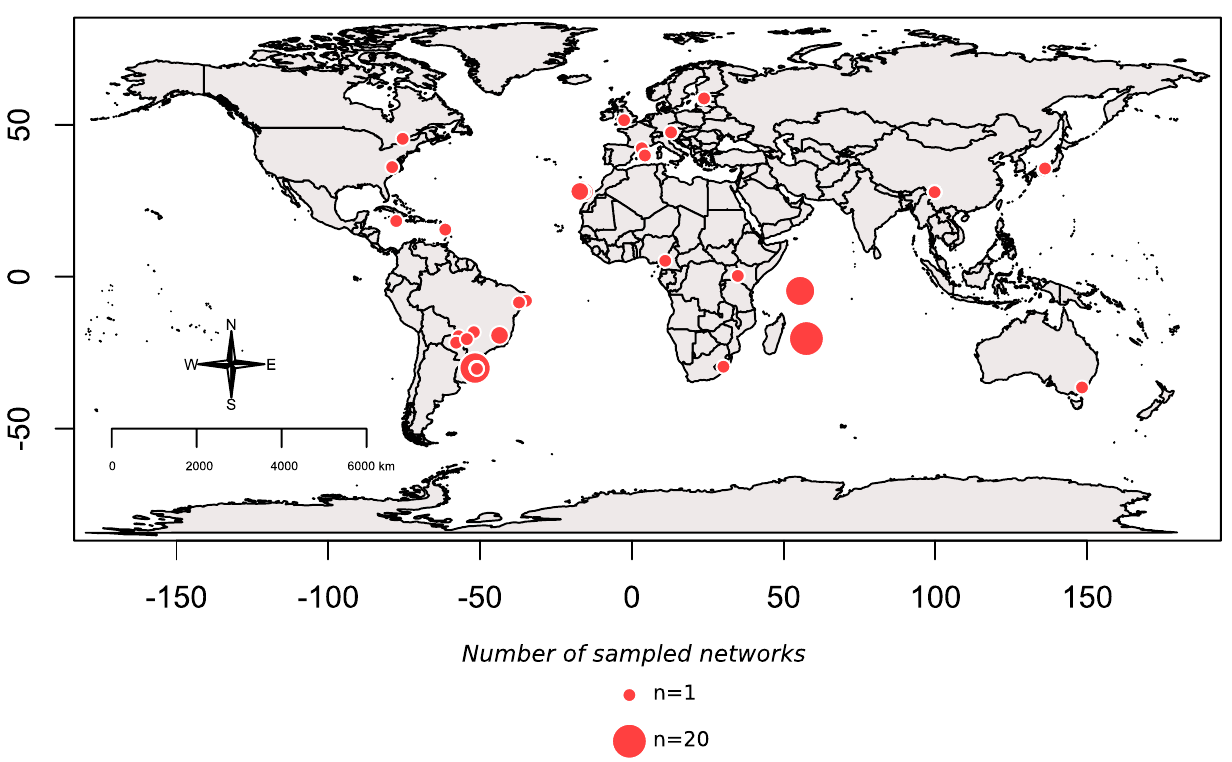
Figure 1. World map showing the spatial distribution of the 109 weighted pollination networks compiled in this study. Although some networks were sampled within the same or nearby sites, they are at 68 different geographic coordinates.